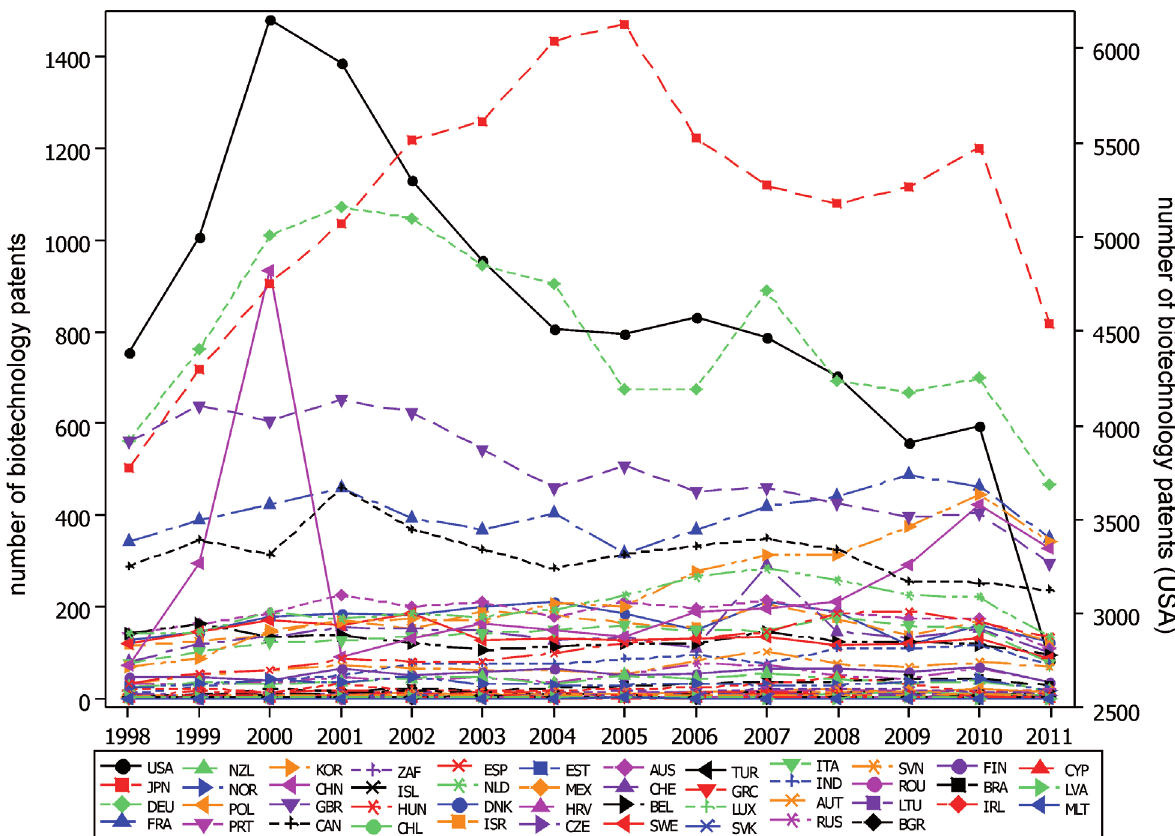
Fig. 2. Number of PCT patent applications in selected countries of the world, 1998–2011 Source: own calculations based on OECD